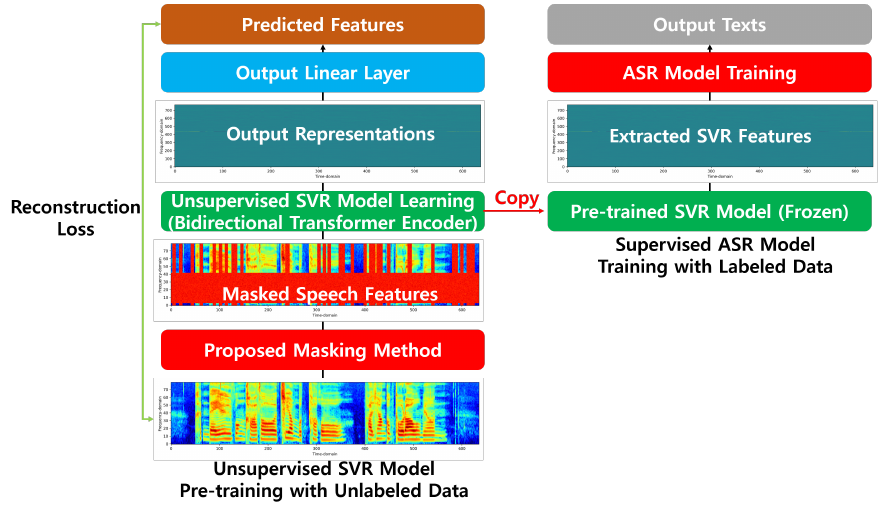
Figure 1. Illustration of the proposed overall architecture for unsupervised SVR pretraining and ASR